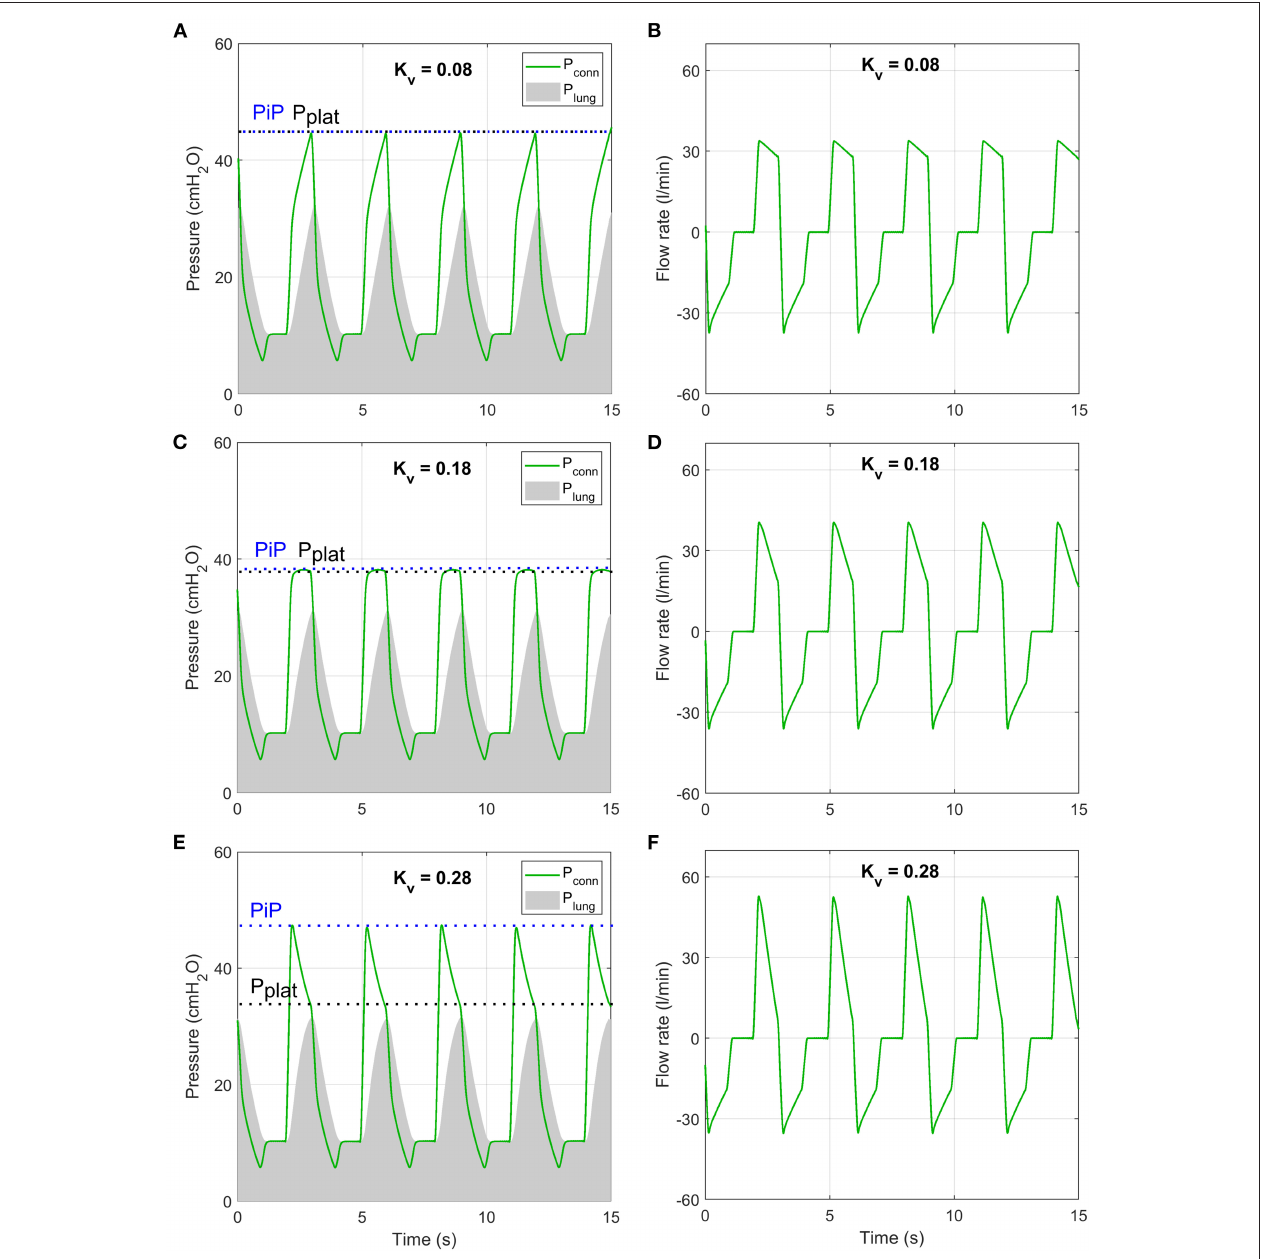
FIGURE 12 | Numerical model predictions of pressure (A,C,E) and flow rate (B,D,F) under conditions of ISO 80601-2-12:2020 test case 4 (purple lines in Figure 11 ) at three values of K v , C that are representative of three inhalation regimes.